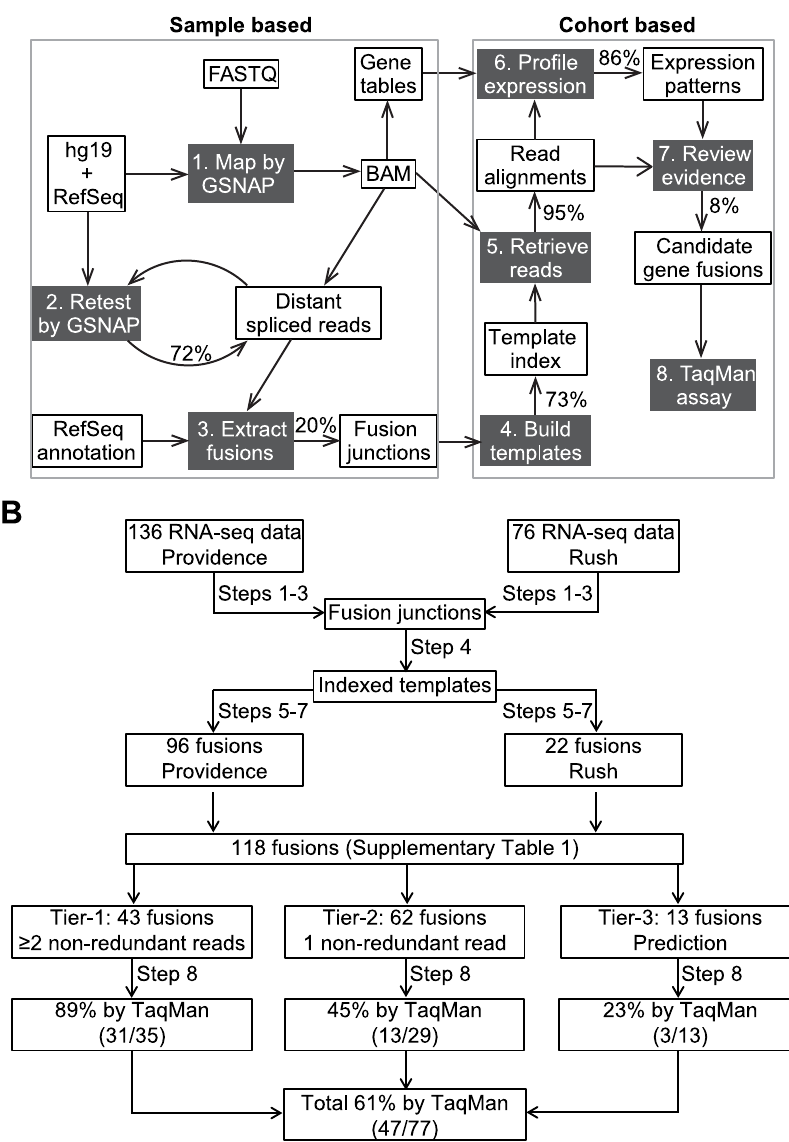
Figure 1. The schema and workflow of our fusion detection pipeline gFuse, illustrated for two breast cancer cohorts. A. The sample and cohort based strategies are integrated in RNA-Seq fusion transcript detection. Each step of the pipeline is numbered in shade, and explained in Materials and Methods. The percentages show the fusion junctions retained after each step in all Providence samples. B. Dataflow and main results of fusion events detected in Providence and Rush are shown side-by-side with each step corresponding to the numbered step in Figure 1A. The numbers of fusion events selected for TaqMan assays and the TaqMan supported ones are in parentheses.